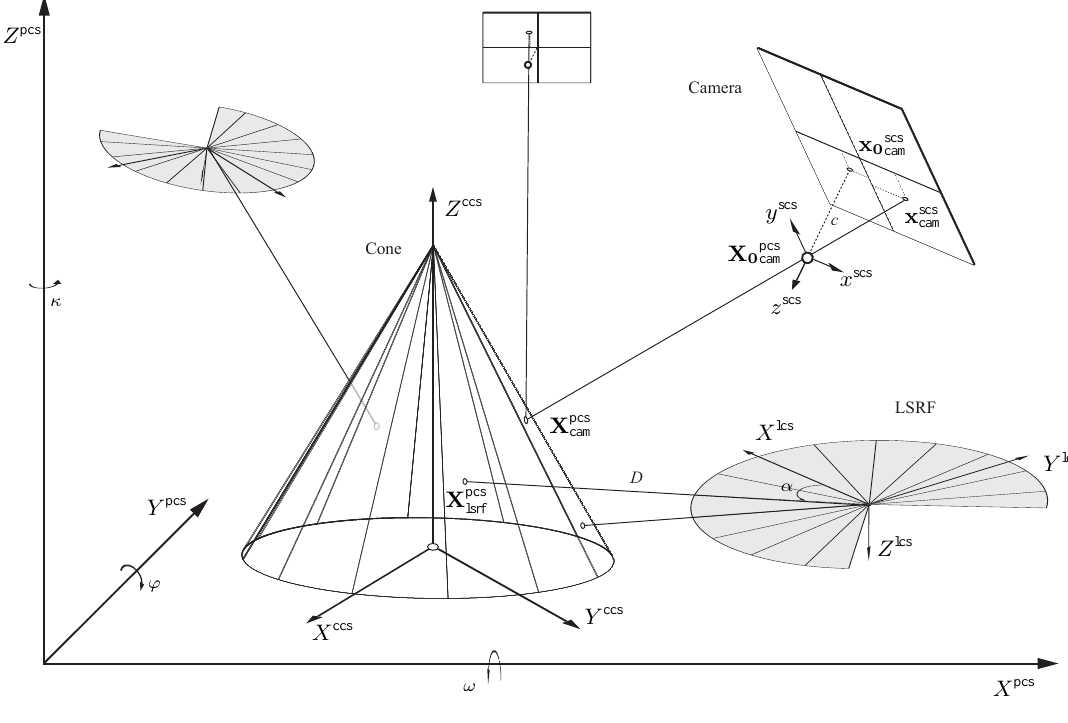
Figure 2: Geometric model.